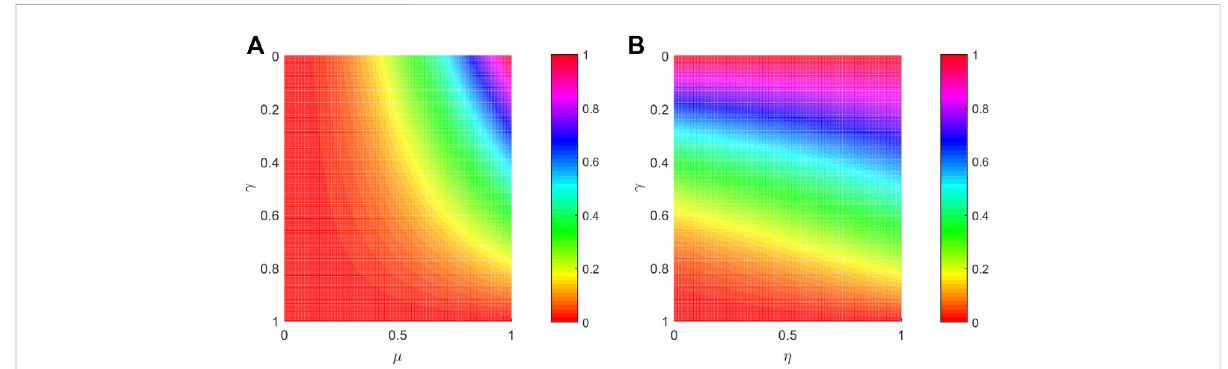
FIGURE 2 (color online) (A) Teleported QFI F CAD as a function of γ and μ with η = 0.8. (B) Teleported QFI F CAD as a function of γ and η with μ = 0.8. The . polarization parameter θ is π 2